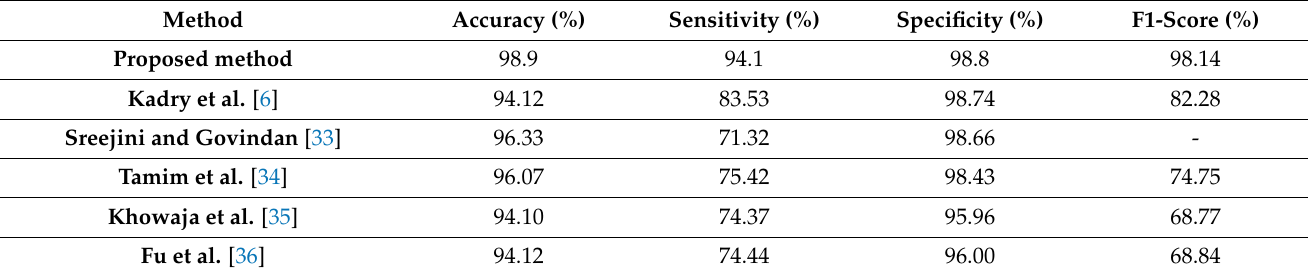
Table 1. Results from the image segmentation using the U-Net++ neural network on the DRIVE database.